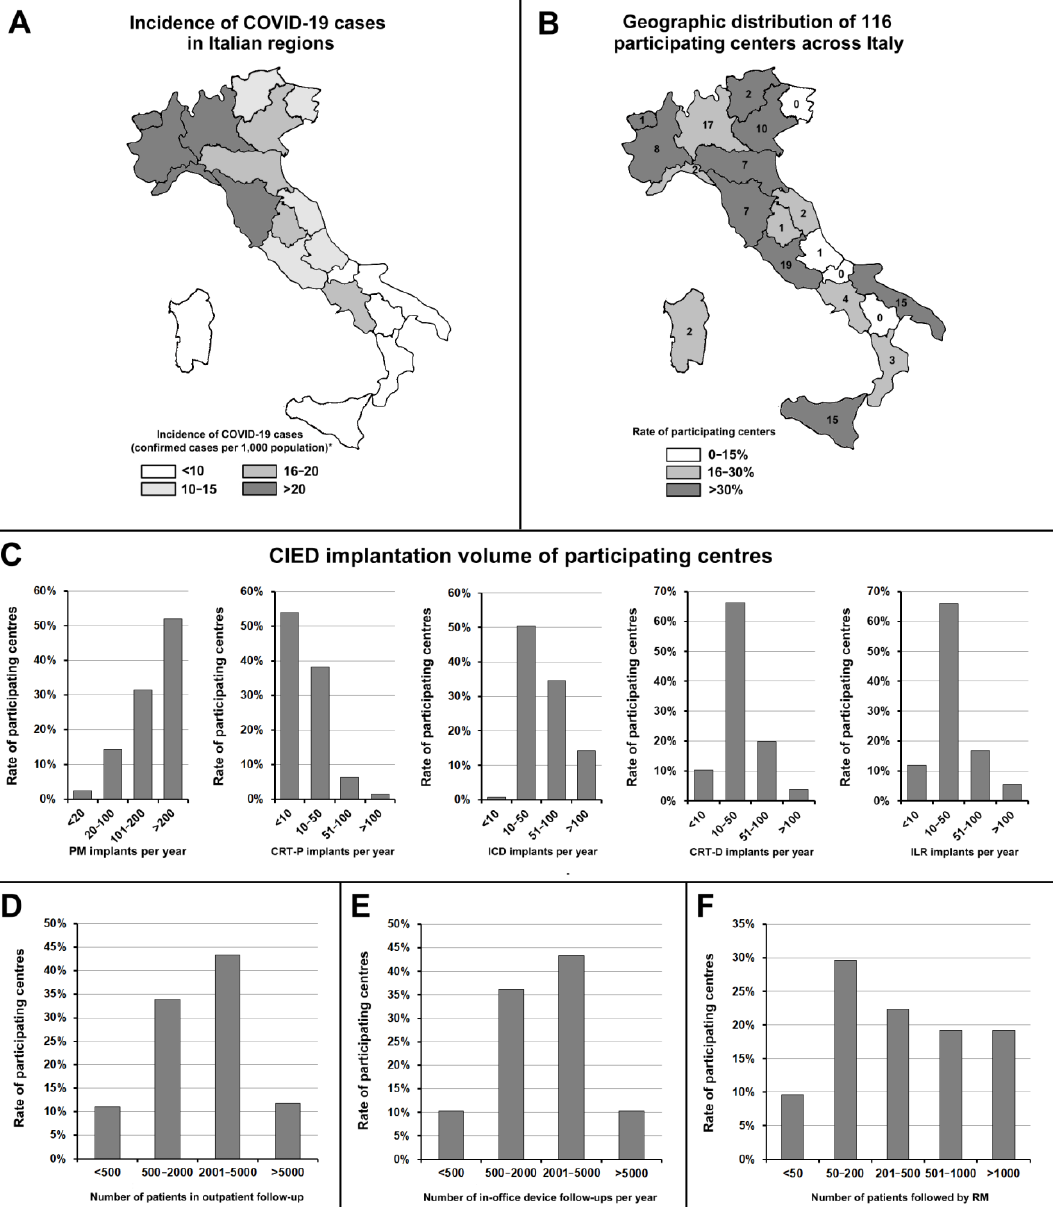
Figure 1. ( A ) Incidence of COVID-19 cases in Italian regions. ( B ) Geographic distribution of the centres that responded to the survey across Italy. ( C ) CIED implantation volume of participating centres. ( D ) Number of patients in outpatient follow-up. ( E ) Annual number of in-office device follow-up examinations performed by the participating centres. (F ) Number of patients followed up by remote monitoring. * Data from Italian Civil Protection Department [4]. CIED, cardiac implantable electronic device; CRT-D, cardiac resynchronisation therapy combined with defibrillator; CRT-P, cardiac resynchronisation therapy combined with pacemaker; ICD, implantable cardioverter-defibrillator; ILR, implantable loop recorder; PM, pacemaker; RM, remote monitoring.